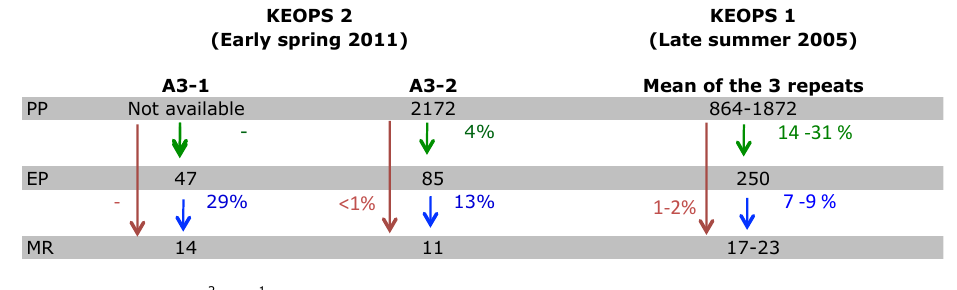
Figure 6. Schematic, comparing the fate of POC at station A3 during KEOPS 1 and KEOPS 2 cruises. PP: primary production, EP: export production at 150m depth and MR: mesopelagic POC remineralization deduced from the Ba xs maxima and integrated between 150–400m; all fluxes in mgCm − 2 day − 1 . EP/PP (green values), MR/PP (red values) and MR/EP ( r ratio, blue values) ratios shown as percentage.